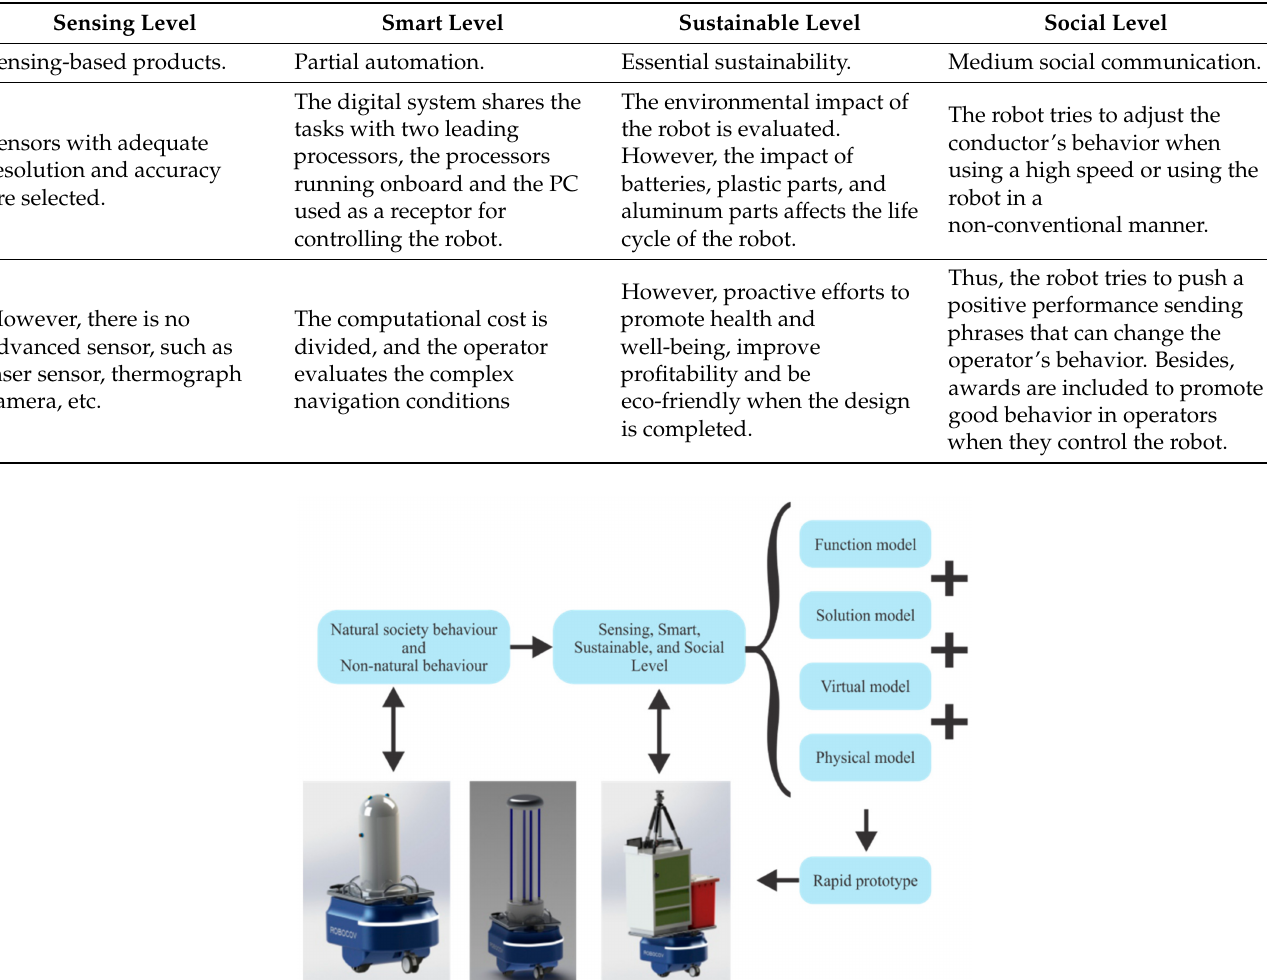
Table 1. S4 Selected Levels for ROBOCOV.